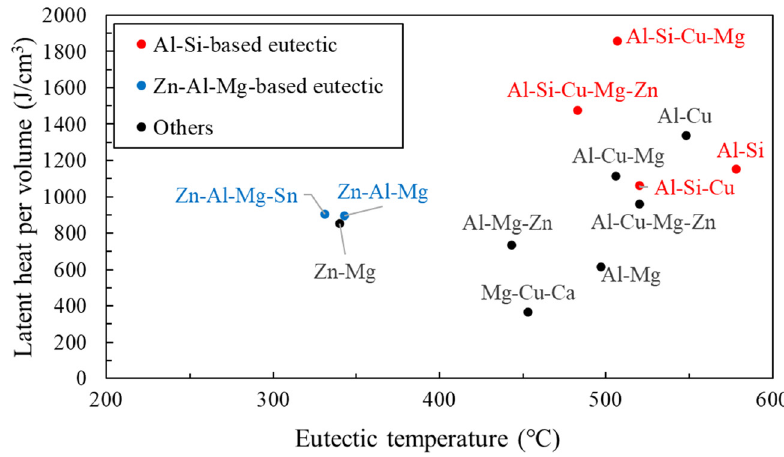
Figure 8: Eutectic temperature and volumetric latent